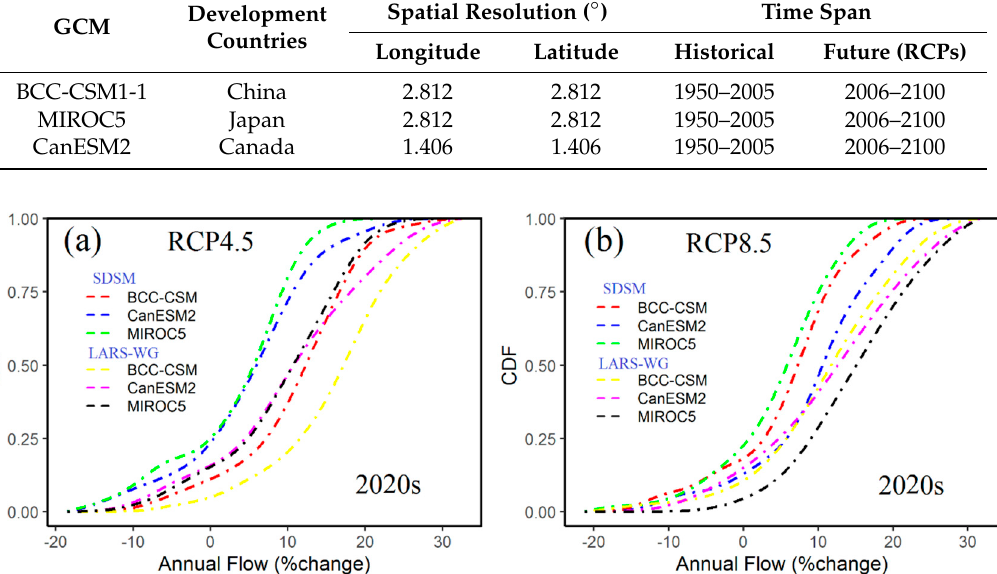
Table A1. Climate models used to project climate change scenarios.